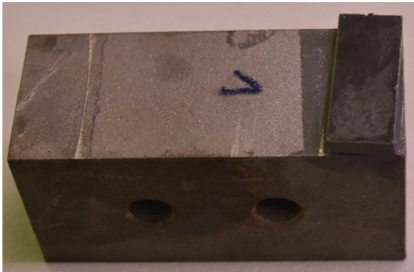
Figure 4: Sample with the upper element rotated at an angle of approximately 3.7 °